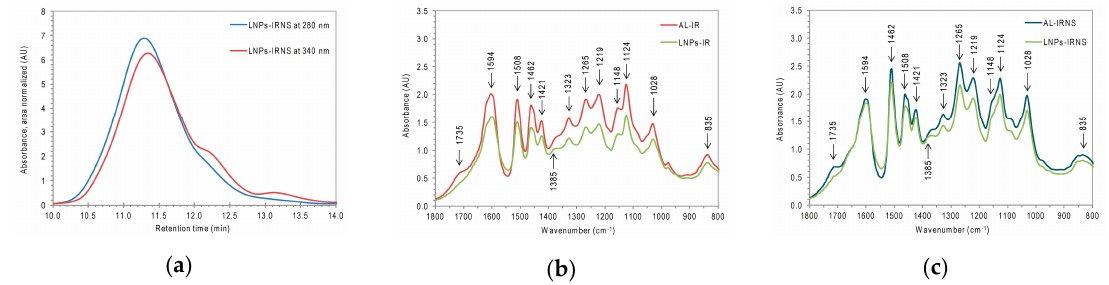
Figure 6. ( a ) HP-SEC elution curves of the dried lignin nanoparticles fractions from mixed sawdust re-dissolved in 10 mM NaOH (LNPs-IRNS) at 280 and 340 nm; ( b ) and ( c ) FTIR spectra of the Acidolysis lignin fraction from Iroko and Iroko–Norway spruce sawdust (AL-IR, AL-IRNS) and of their respective freeze-dried lignin nanoparticles (LNPs-IR, LNPs-IRNS).